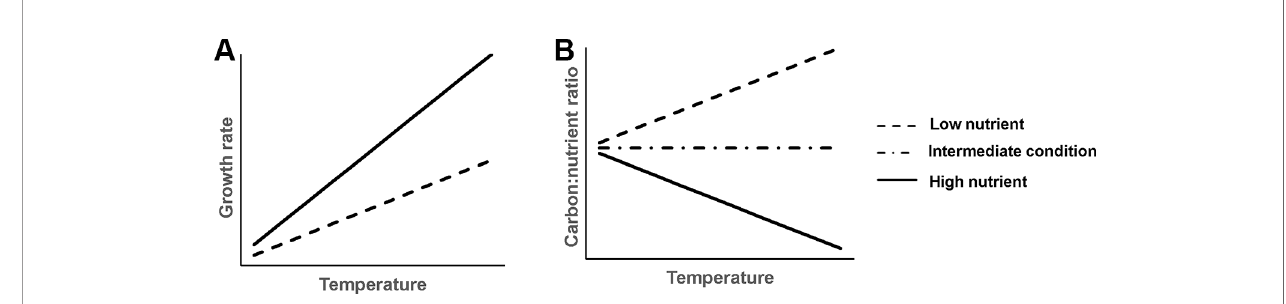
FIGURE 1 | Schematic graph of hypothesized temperature effects on aquatic plant growth rate (A) and plant C:nutrient ratio (B) at different sediment